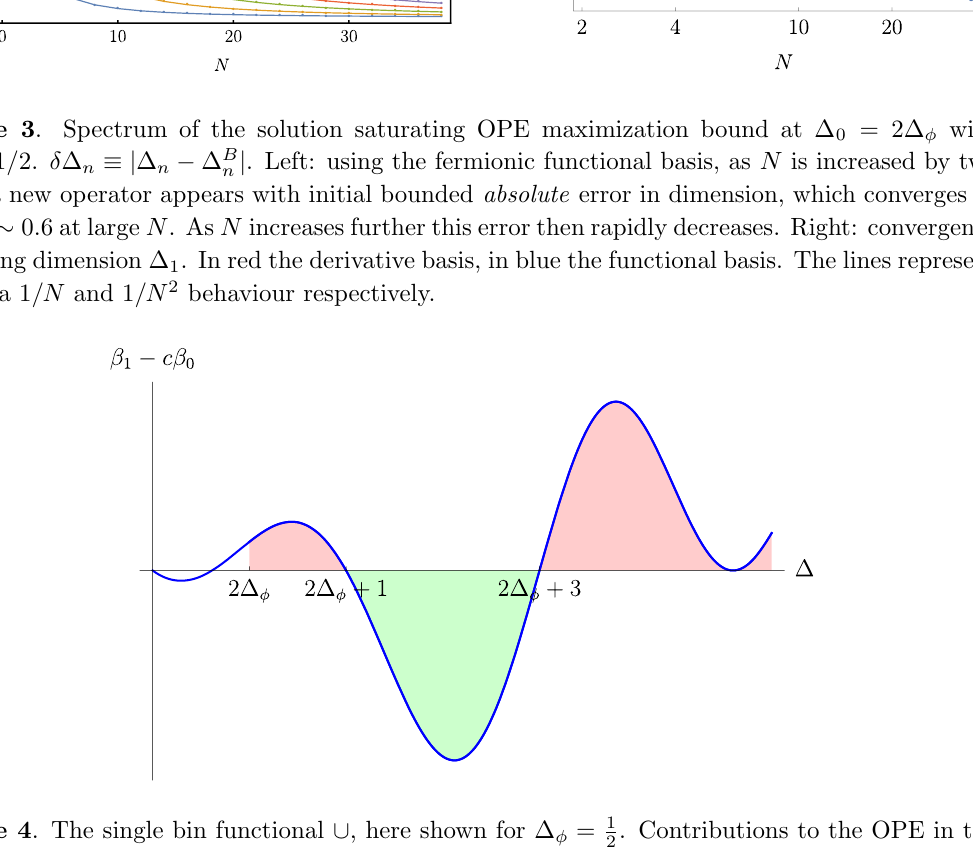
. Contributions to the OPE in the 2